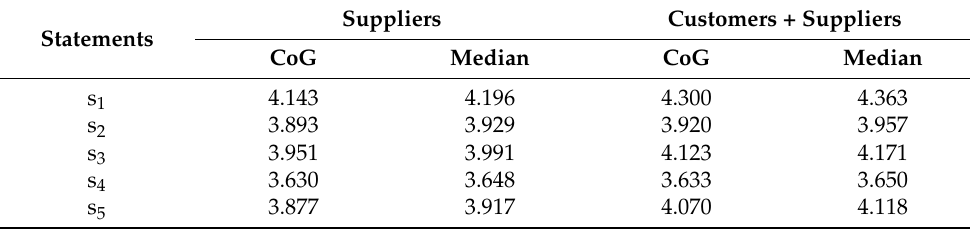
Table 7. Average ratings of the statements presented by the enterprise representatives after defuzzifi- cation the triangular fuzzy numbers (a group of suppliers vs. a group of customers and suppliers jointly).